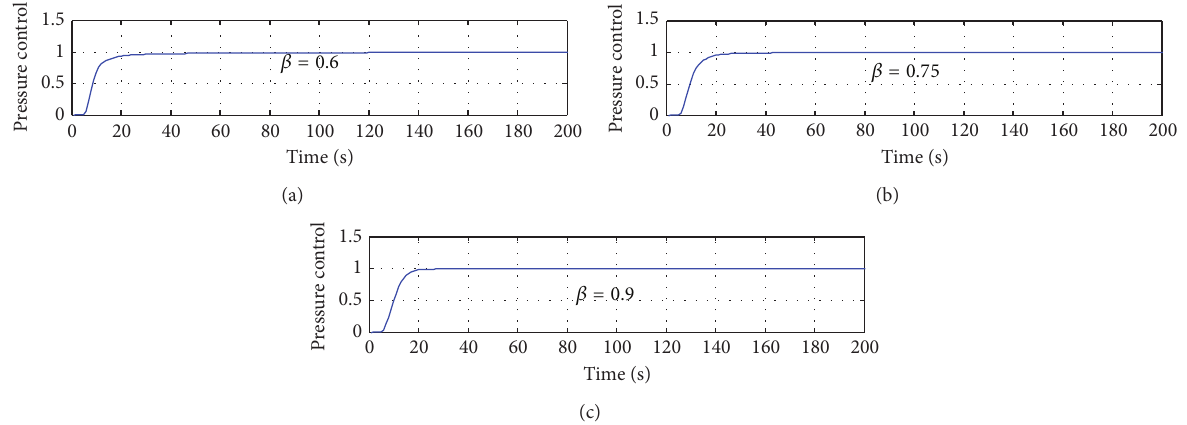
Figure 8: Step response of the nozzle-amplifier-relay (17) for various